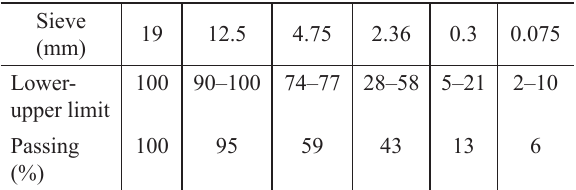
Table 1. Gradation of aggregates used in the study